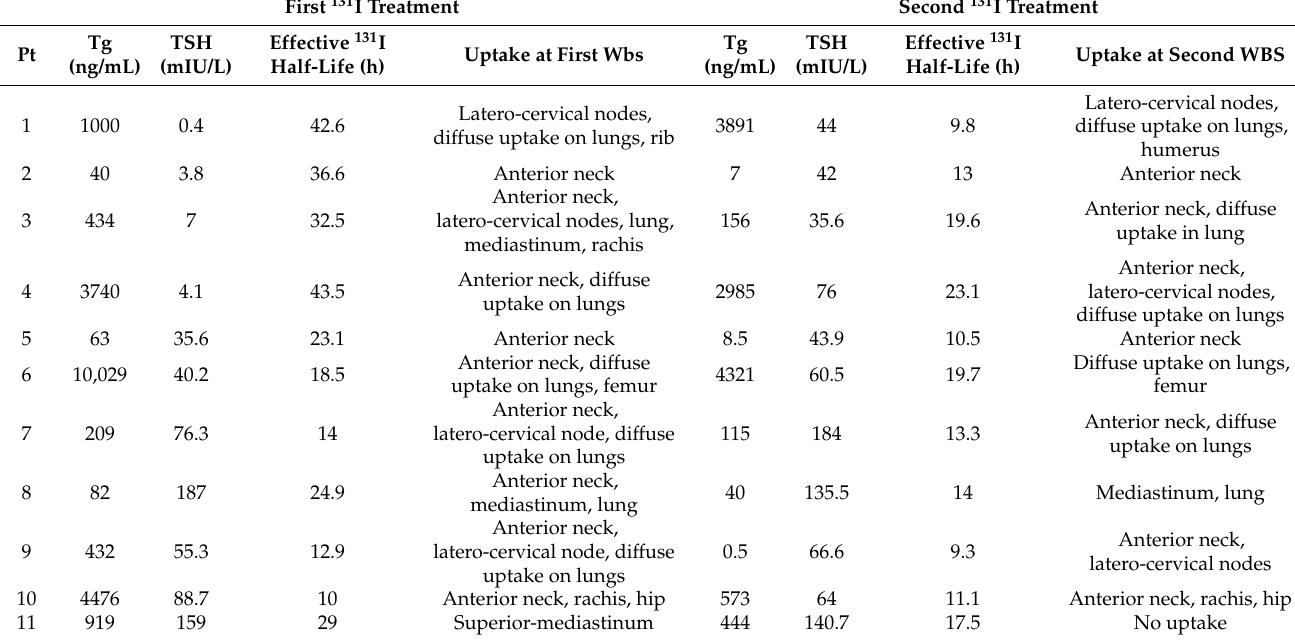
Table 3. WBS results of the 11 patients for whom two consecutive sets of data concerning 131 I whole-body retention are